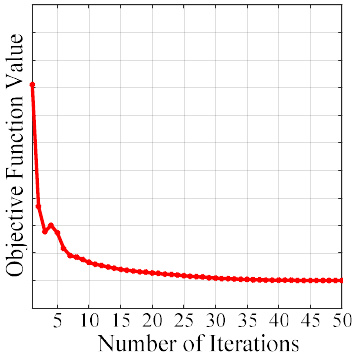
Figure 3. Convergence Curve of DLRSD